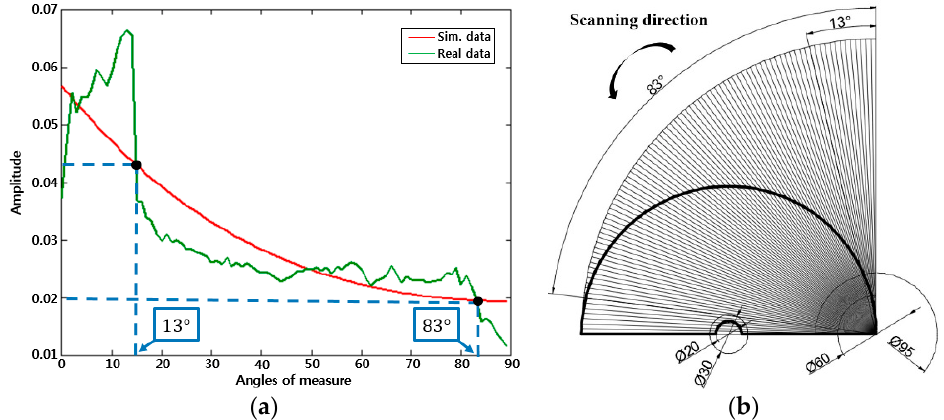
Figure 22. The attenuation curve of Lamb wave obtained from the experiment: ( a ) Attenuation curve; ( b ) Schematic of scanning direction.